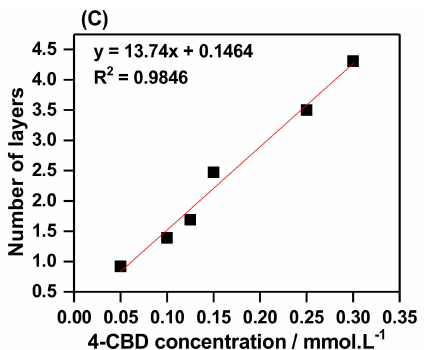
Figure 6. ( A ) CVs for 0.050, 0.10, 0.125, 0.15, 0.25, and 0.30 mmol / L of 4-CBD (black line) and blank (blue line), 0.70 to − 0.70 V at 0.10 V.s − 1 , the arrow shows direction of scan; ( B ) Peak current vs. 4-CBD concentration; and ( C ) Number of layers after a single cycle vs. 4-CBD concentration.